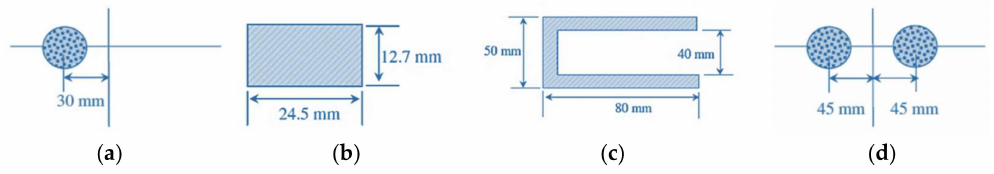
Figure 1. Targets from 2001 Fresnel dataset: ( a ) DielTM target; ( b ) RectTM_Dece target; ( c ) U-TM-shaped target, and ( d ) TwinDielTM